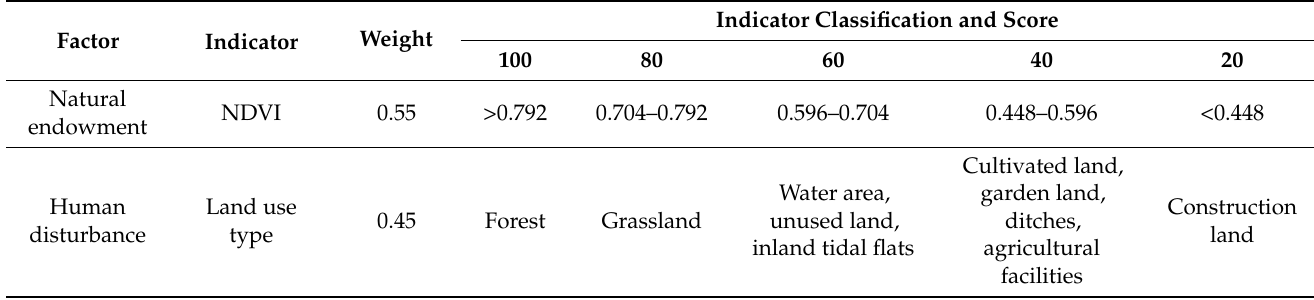
Table 3. Evaluation index system for ecological land suitability.